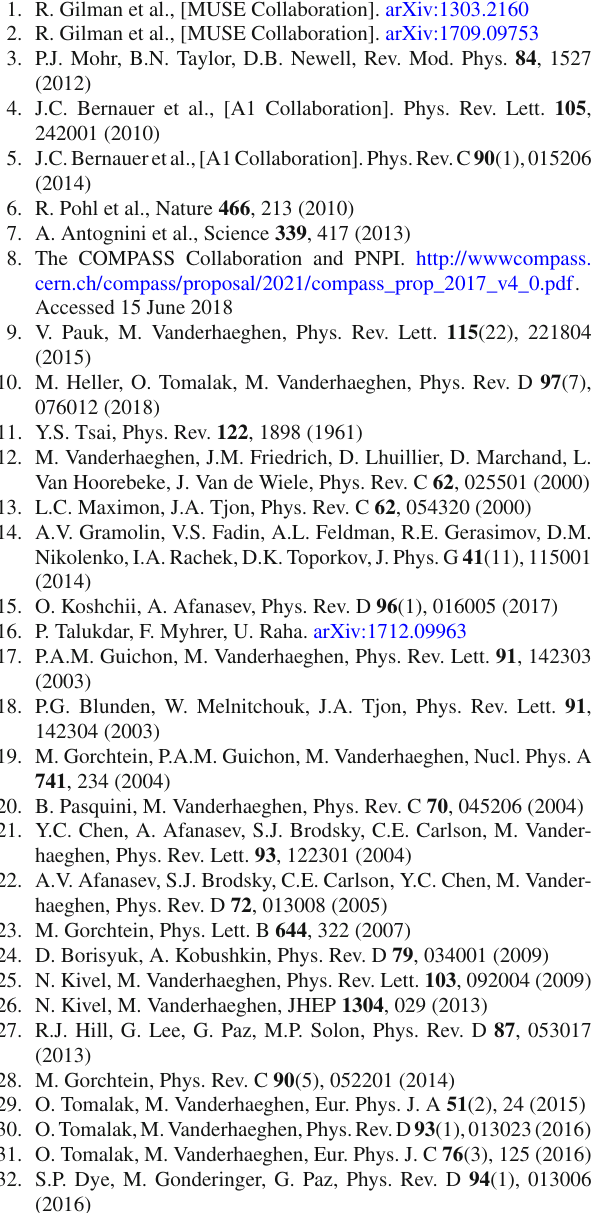
Consequently, all real parts of the TPE amplitudes in the box graph model are reconstructed using once-subtracted DRs. The three amplitudes G 2 TPE amplitudes, which are required for the evaluation of